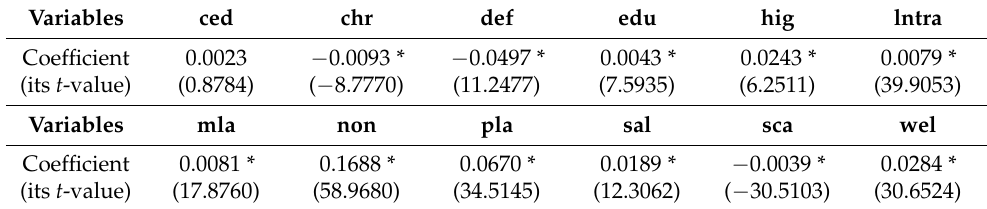
Table 4. Results of multiple linear regression analysis of ACI.